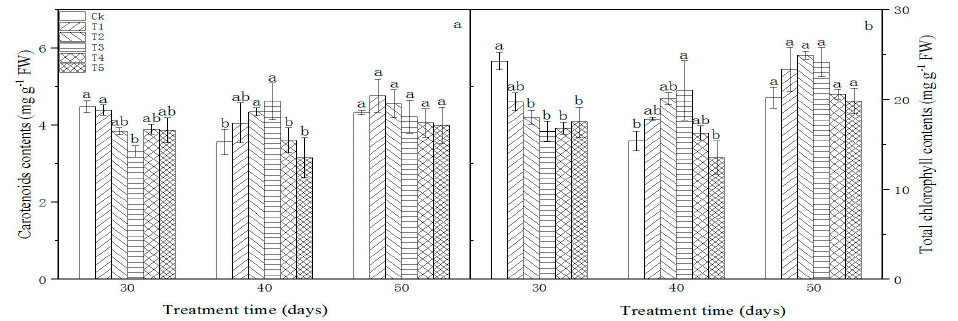
Figure 8. Pigment contents of L. olgensis leaves with different graphene treatments (mean ± 1 S.D., n = 3). FW = fresh mass. Values followed by the same letter for the same days are not significantly different at p < 0.05. Ck, T1, T2, T3, T4, and T5 represent 0, 25, 50, 100, 250, and 500 mg L -1 graphene treatments, respectively. ( a ): carotenoid contents; ( b ): total chlorophyll contents.